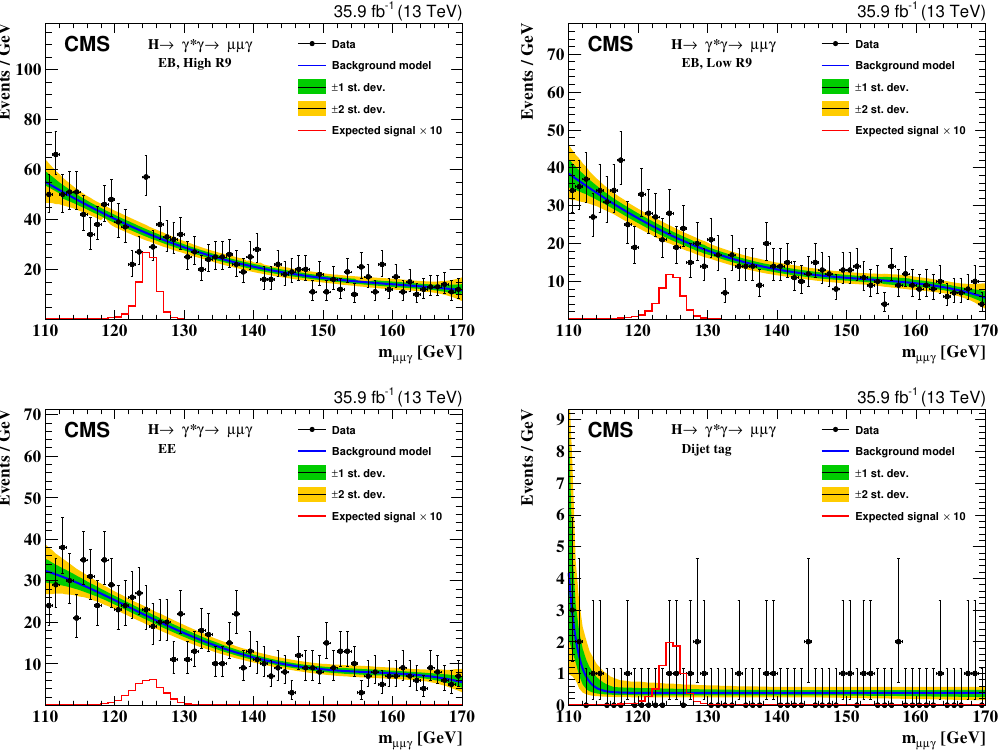
Figure 2 . Background model (cid:12)t to the m (cid:22)(cid:22)(cid:13) distribution for EB-high R 9 (upper left), EB-low R 9 (upper right), EE (lower left) and dijet tag (lower right) for the H green and yellow bands represent the 68 and 95% CL uncertainties in the (cid:12)t to the